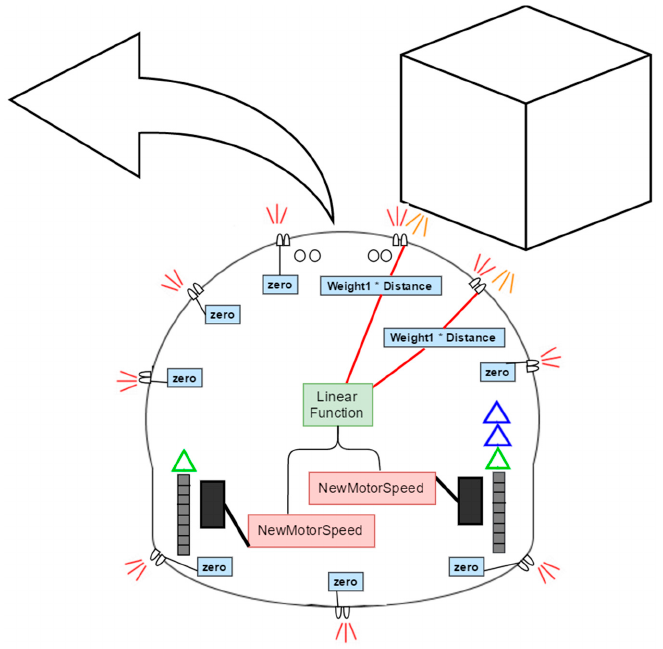
Figure 3. The obstacle avoidance mechanism as implemented in the mobile robot platform.